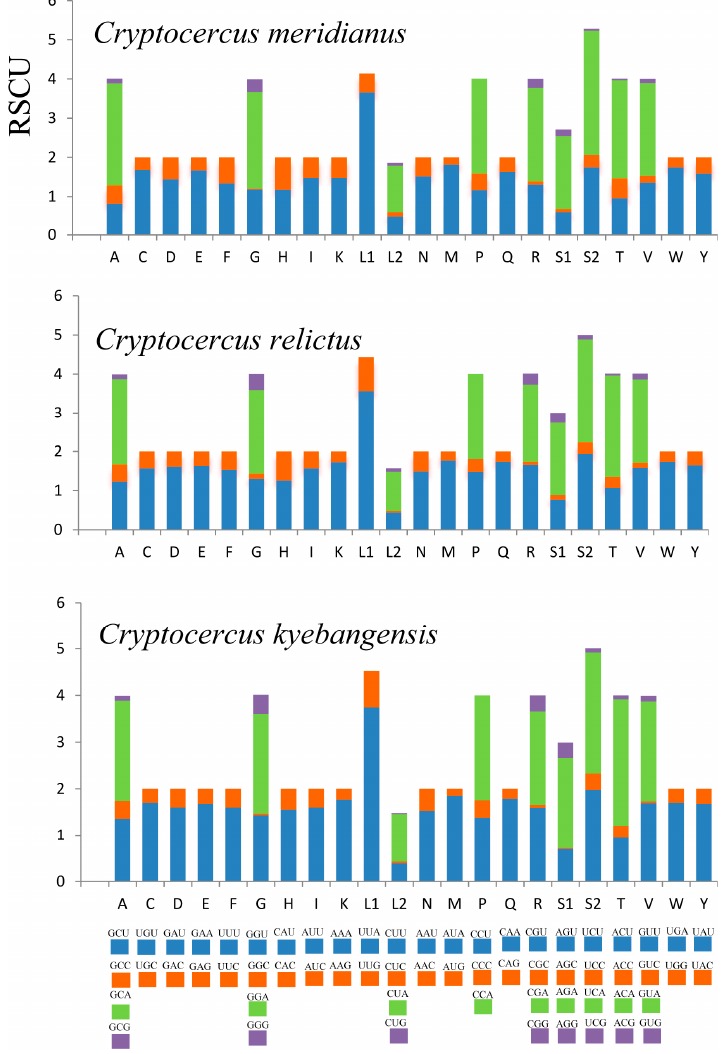
Figure 2. Relative synonymous codon usage (RSCU) for protein coding genes of the three Cryptocercus mitochondrial genomes. Codon families are provided on the x -axis.